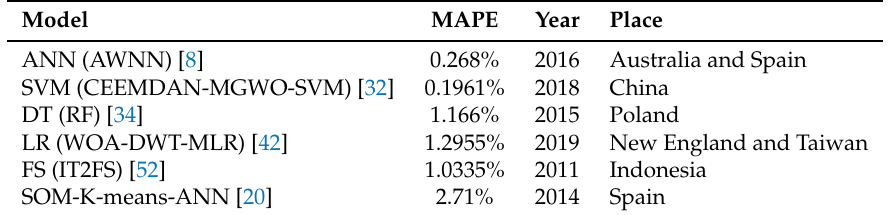
Table 1. The results of MAPE of comparison for 6 forecasting